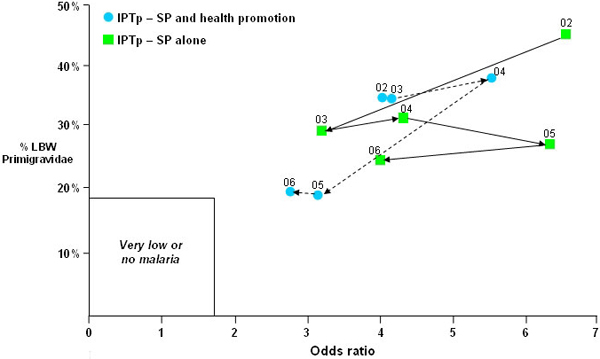
Annual birthweight indicators for singleton pregnancies reported by DELIMAL health centres in Burkina Faso between 2002–2006 (pre-intervention, and intervention April 2004–2006). Point values indicate the year of data collection. The odds ratio refers to excess low birthweight (<2500 g) prevalence in primigravidae compared to multigravidae. Areas receiving SP-ITPp intervention alone (■); areas receiving SP-ITPp combined with a pregnancy health promotion campaign (●).